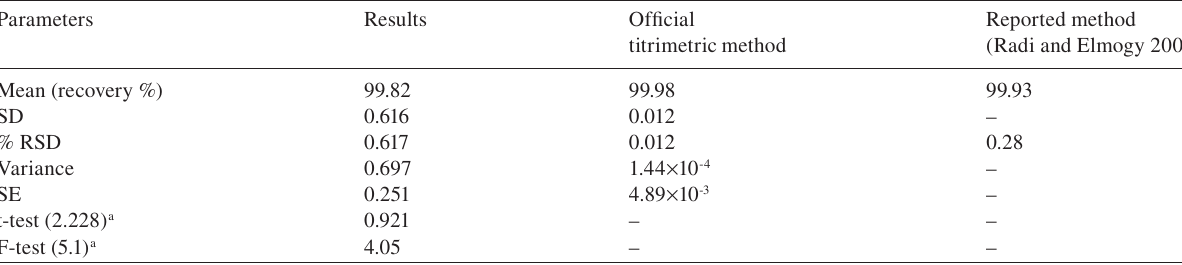
Table 3 Comparison of the proposed and reported methods for determination of carvedilol. Parameters